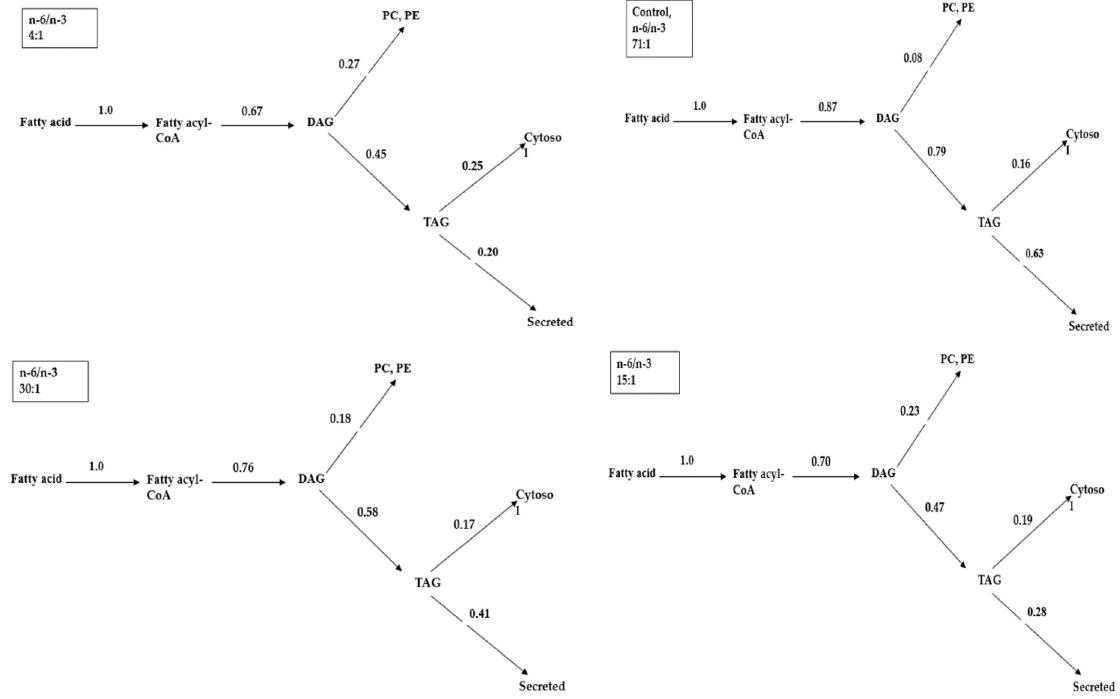
Figure 1. Metabolic distribution of acyl moieties flux for oxidation and glycerolipid synthesis in the liver of obese animal biomodel rat-fed diets containing different n-6/n-3 ( n = 6). DAG, diacylglycerol; TAG, triacylglycerol; PC, phosphatidylcholine; PE, phosphatidylethanolamine.